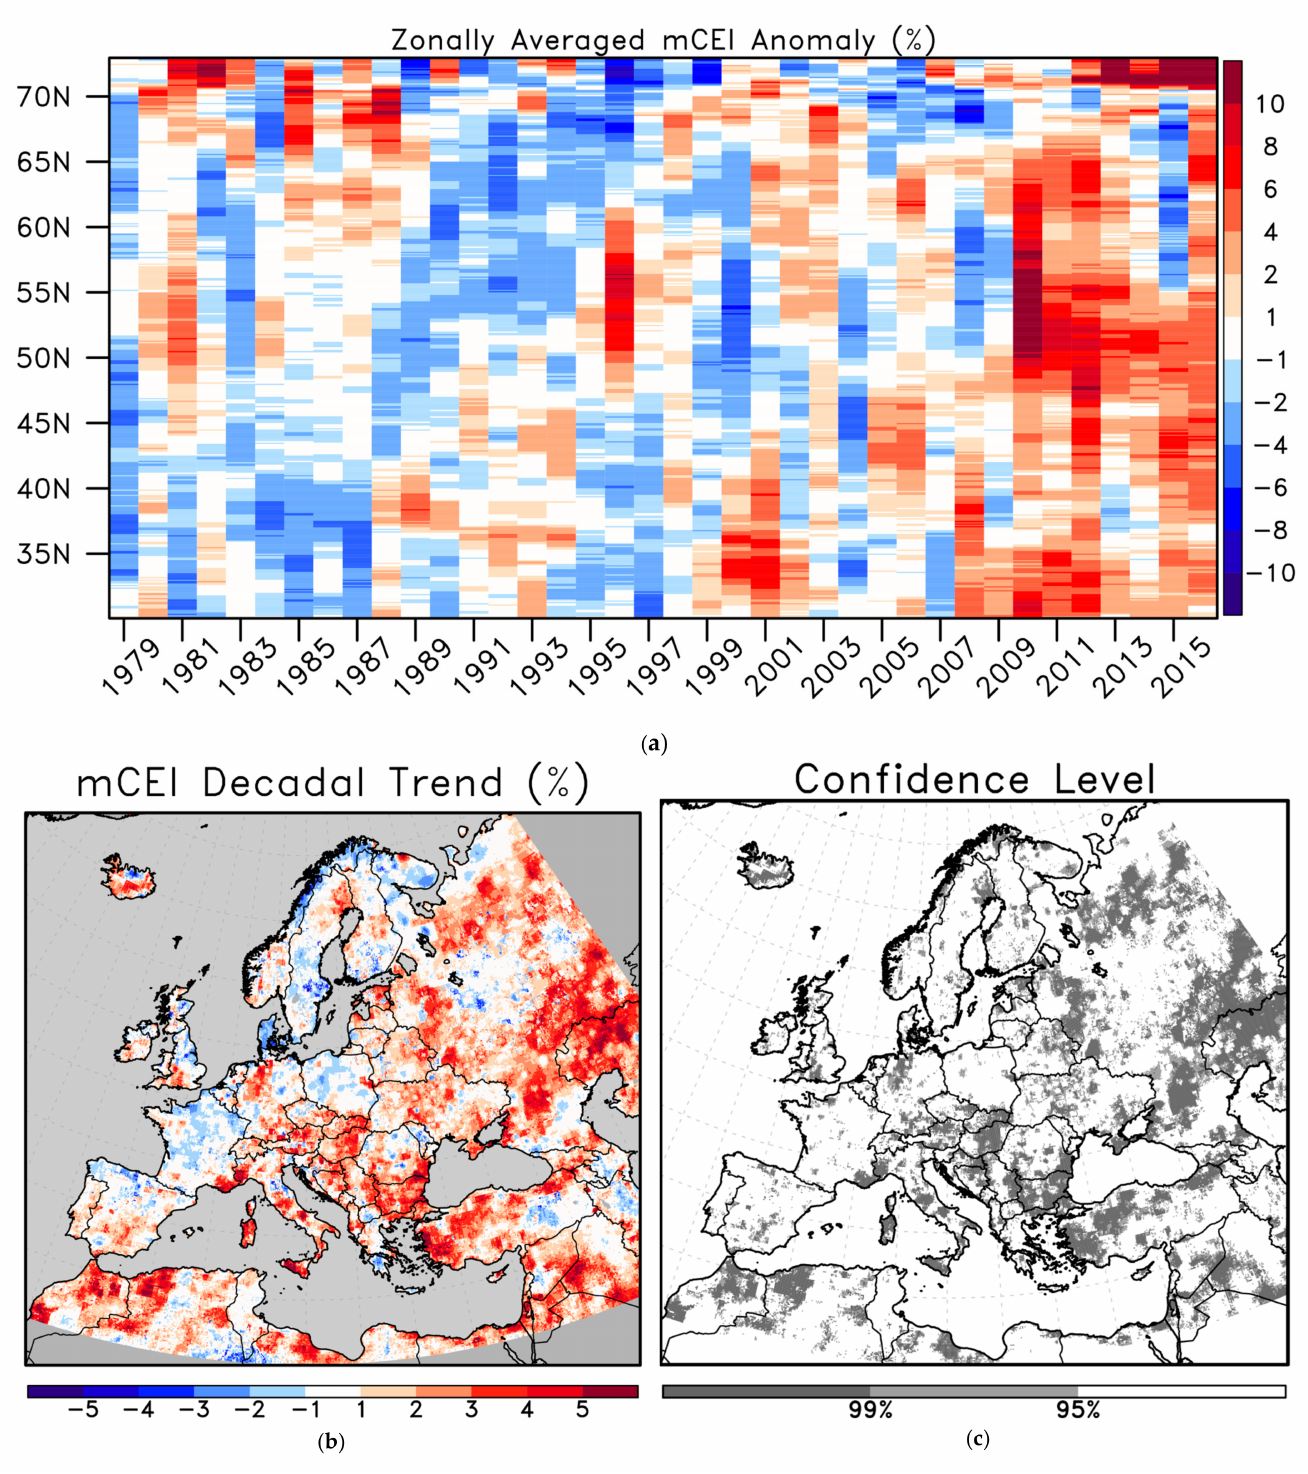
Figure 8. ( a ) Zonally averaged mCEI anomaly, ( b ) decadal trend map of mCEI (% decade − 1 ), and ( c ) confidence level of the